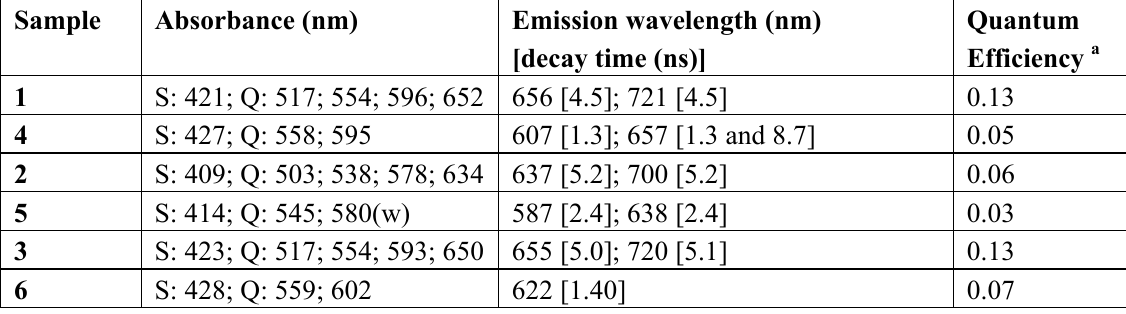
Table 2 : Photophysical parameters of asymmetrical TPPs in